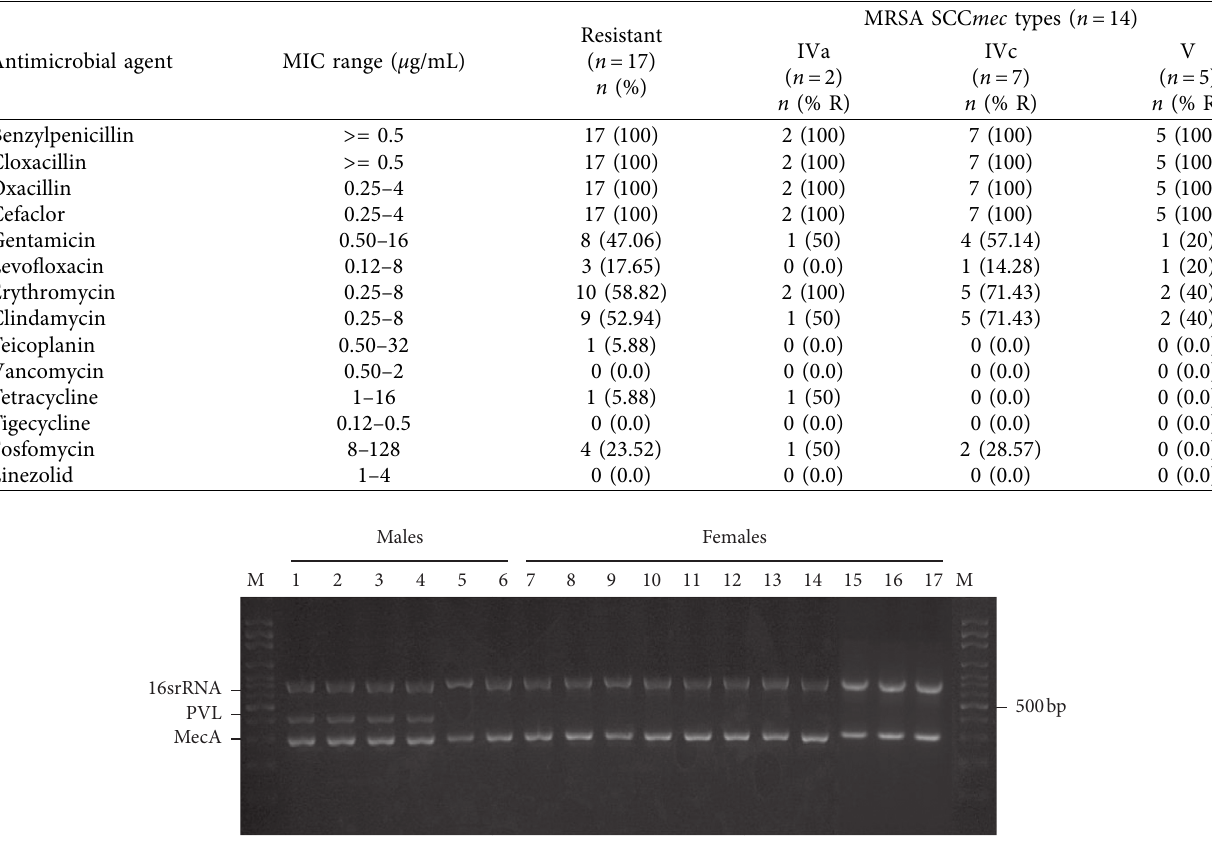
Figure 1: Multiplex PCR assay for the detection of PVL and mecA genes. M:100bp DNA marker, lanes 1 to 6: MRSA isolates from men, and lanes 7 to 17: MRSA isolates from women. 16 srRNA: 16S rRNA gene amplicon (762 bp), PVL: lukS/F-PV amplicon (433 bp), and MecA: mecA amplicon (310bp). Table 2: mecA gene, PVL gene, and SCCmec types in MRSA